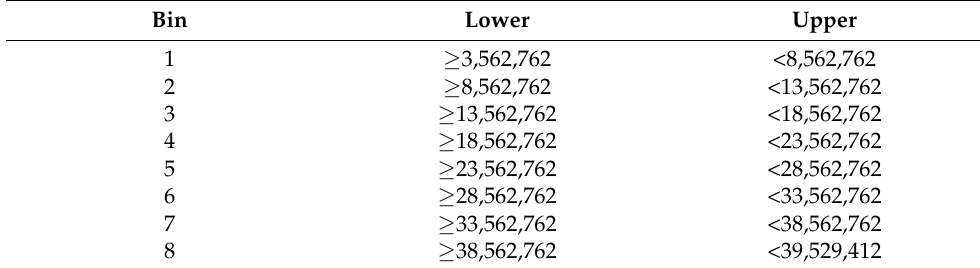
Table 2. External temperature